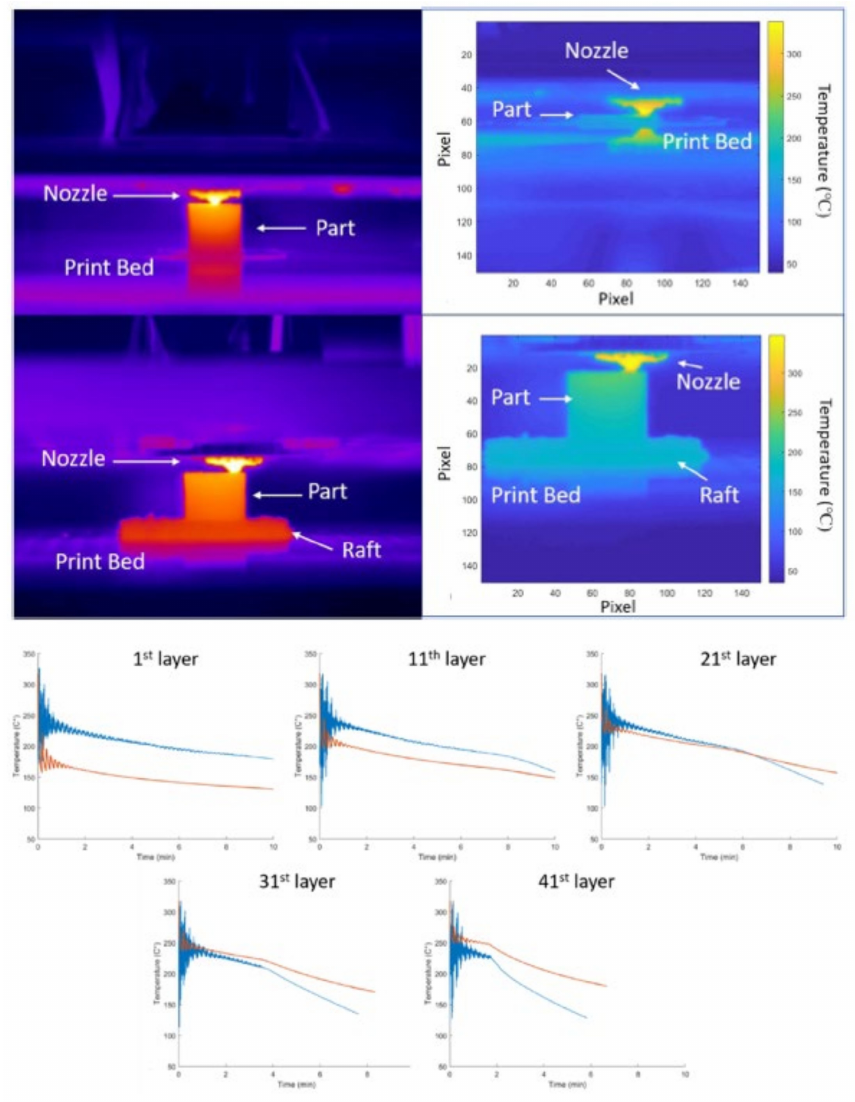
Figure 11. Experimental set-up showing the thermogram of the printed part and the location of the fixed points (reprinted with permission from